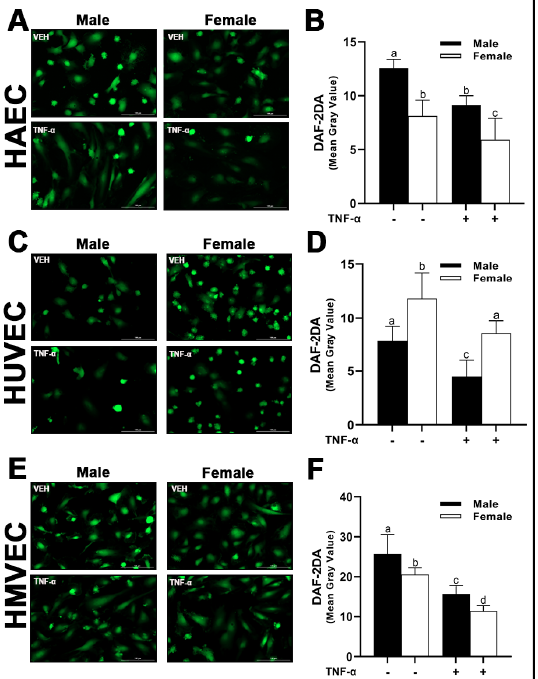
Figure 10. Nitric oxide bioavailability in male and female endothelial cells. HAECs, HUVECs and HMVECs were cultured in starvation medium at ~80% confluency for 24 h with or without TNF- α (20 ng/mL). DAF-2DA was detected by fluorescence microscopy ( A , C , E ) at 485/528 (Ex/Em). Fluo- rescent intensity of cells was quantified with Image J ( B , D , F ). Data are expressed as mean ± SD